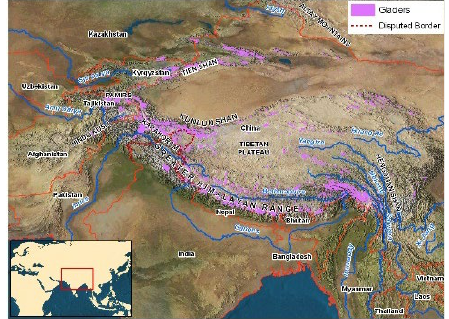
Figure 1. High Asia Mountain ranges, river systems, and glaciers of High